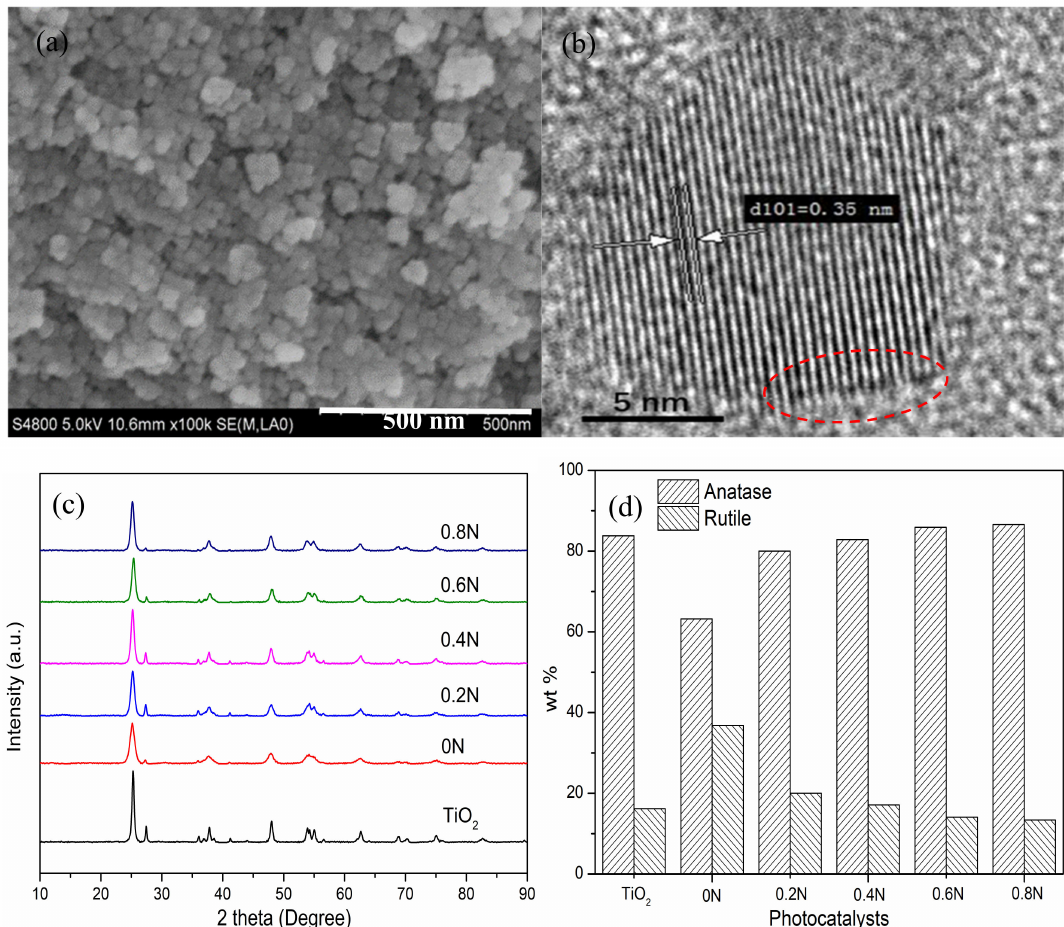
Figure 1. ( a ) SEM and ( b ) high-resolution TEM images of 0.6N; ( c ) XRD patterns and ( d ) phase compositions of di ff erent samples of 0–0.8